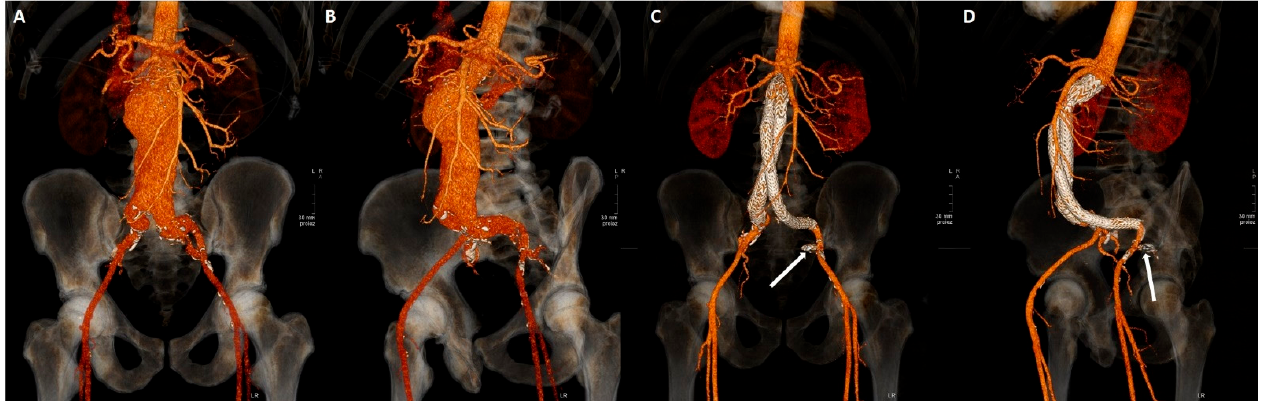
Figure 2. ( A–D ). Volume rendering reconstructions from CTA before ( A , B ) and after ( C , D ) EVAR procedure with left ipogastrigc embolization with coils (arrow) .